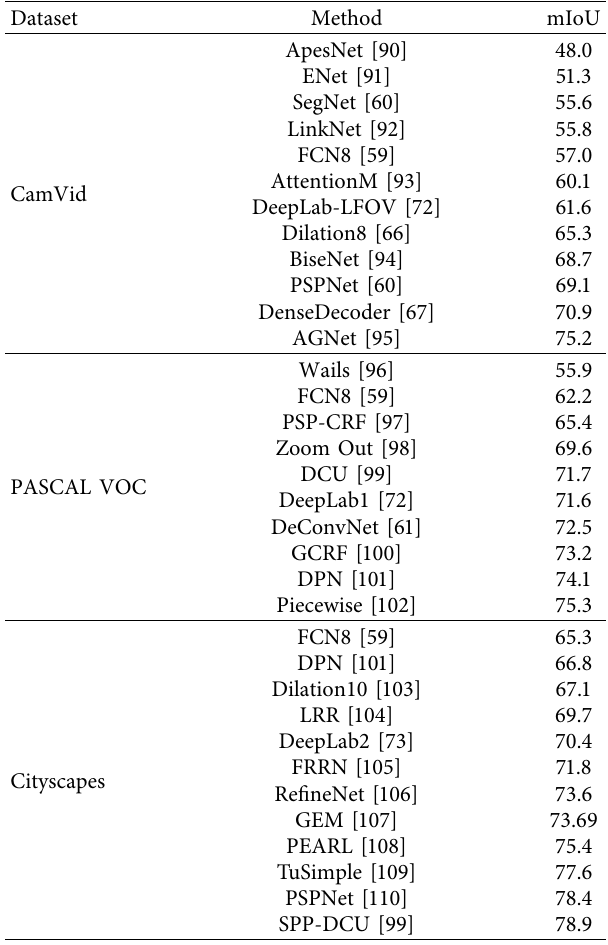
Table 1: Class pixel label distribution in the CamVid dataset. Dataset